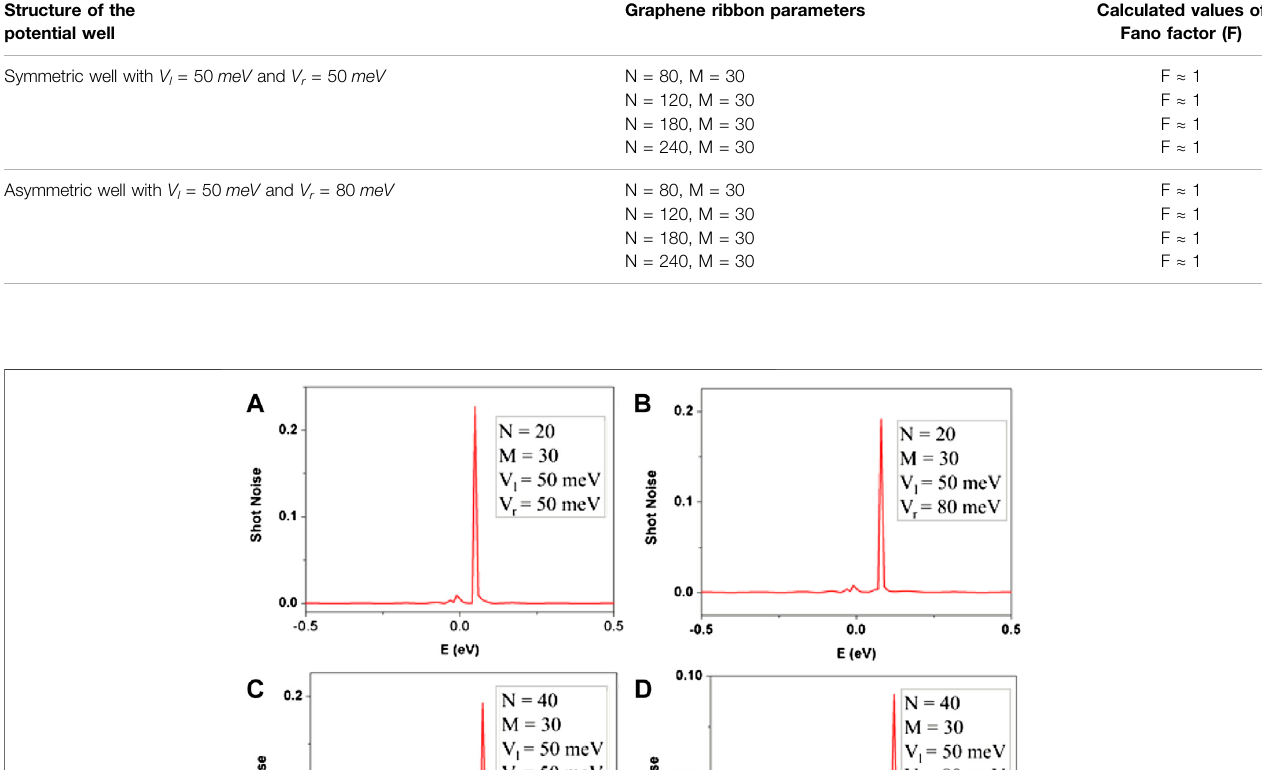
Graphene ribbon parameters